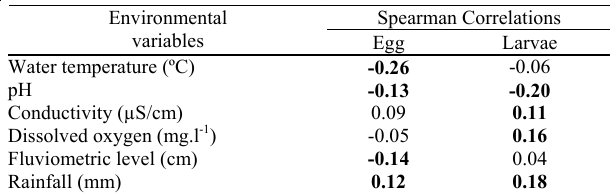
Table 2. Spearman ñ correlations between abiotic variables and the abundance of fish eggs and larvae in the Ilha Grande National Park (in bold are the significative correlations; p <